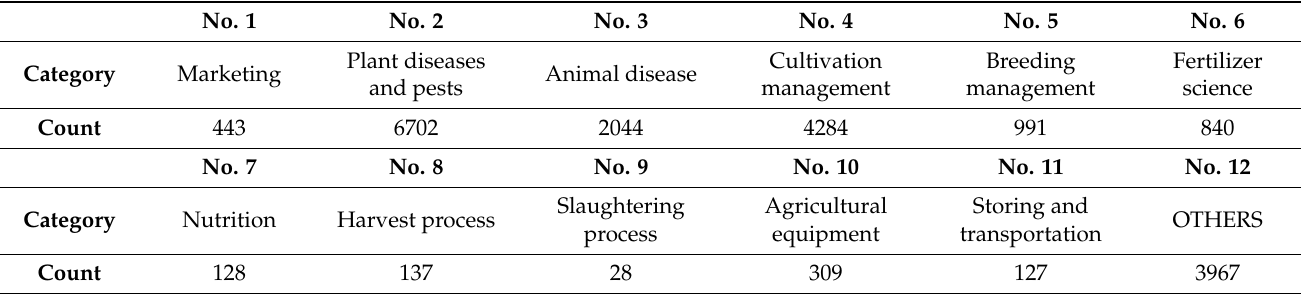
Table 2. Distribution of question categories.